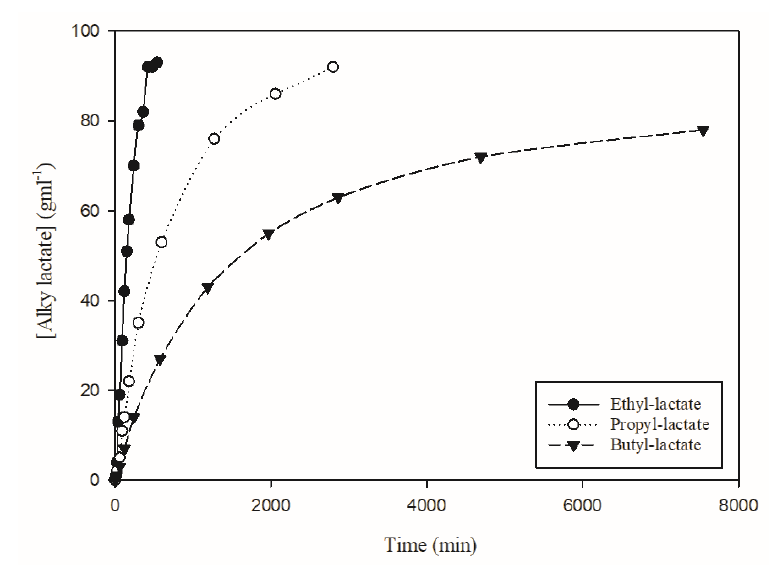
Figure 2. Alky-lactate concentration vs. time for Zn( 1 ) 2 experiments at 90 ◦ C (based on GC and Figure 2. Alky‐lactate concentration vs. time for Zn( 1 ) 2 experiments at 90 °C (based on GC and NMR NMR data). data).